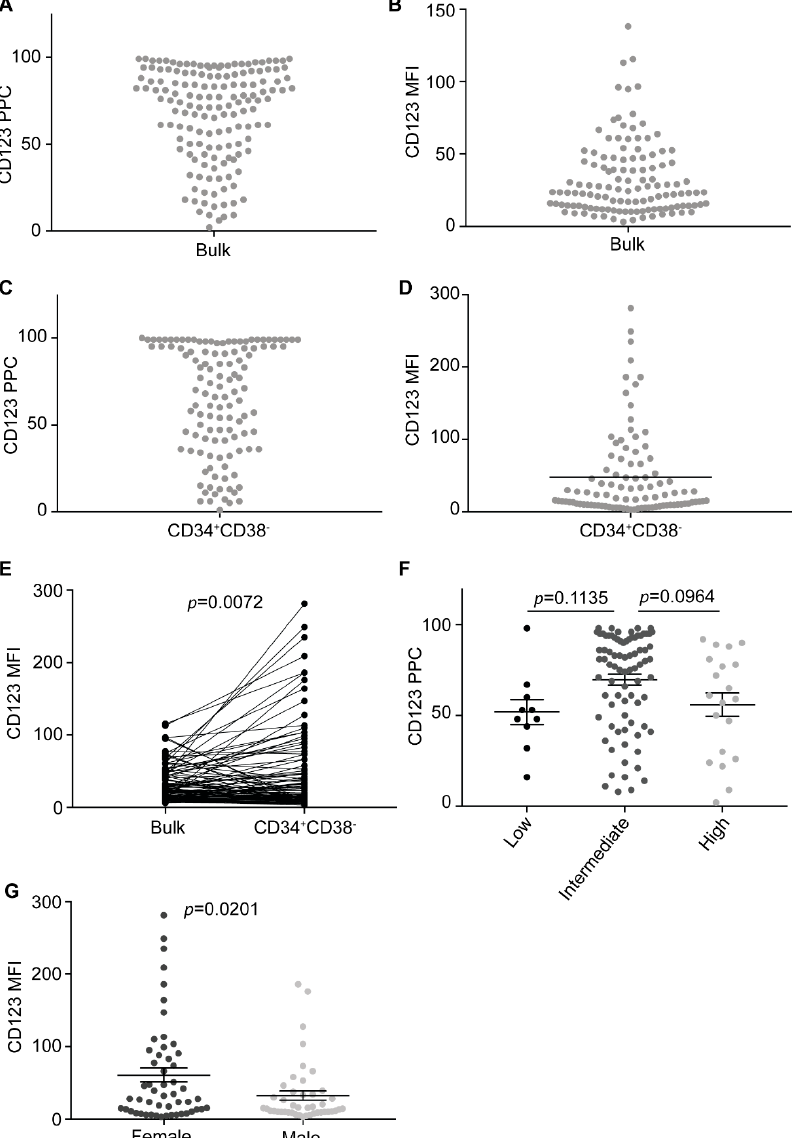
Figure 1. CD123 is ubiquitously expressed in acute myeloid leukemia (AML). ( A ) CD123 percent of positive cells (PPCs) on bulk cells in all samples ( n = 151). ( B ) CD123 mean fluorescence intensities (MFIs) on bulk cells in all samples available ( n = 122). ( C ) CD123 PPCs on CD34 + CD38 − cells in all samples available ( n = 119). ( D ) CD123 MFIs on CD34 + CD38 − cells in all samples available ( n = 96). ( E ) CD123 MFIs on bulk cells compared to CD34 + CD38 − cells at diagnosis in all samples available ( n = 96). Paired t -test. ( F ) CD123 PPCs on bulk cells sorted based on the cytogenetic risk ( n = 111). Cytogenetics characteristics of all patients are reported in Table S1. Multiple comparison test. ( G ) CD123 MFIs on CD34 + CD38 − cells in female and male patients ( n = 96). Unpaired t -test. Bars represent mean and standard